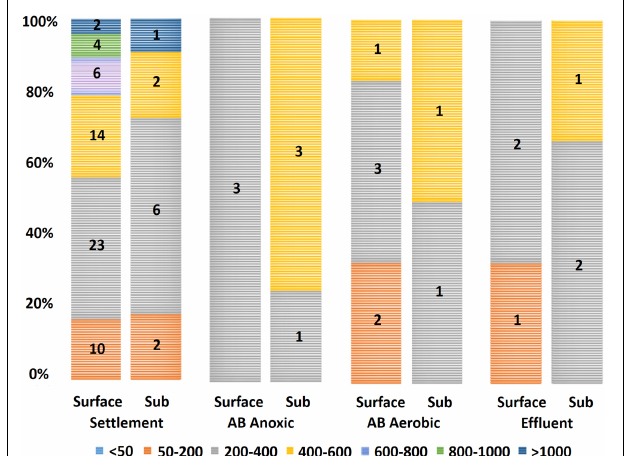
FIGURE 3 | Microplastic size data by wastewater stage (total count of the two sampling visits). Legend entries refer to grouped sizes in micrometers ( µ m). Microplastics with sizes 200–400 µ m had the highest count, with 45% (41/91) falling within this group. No microplastics larger than 600 µ m appeared in samples downstream of the settlement stage. Sub: subsurface; AB: activated